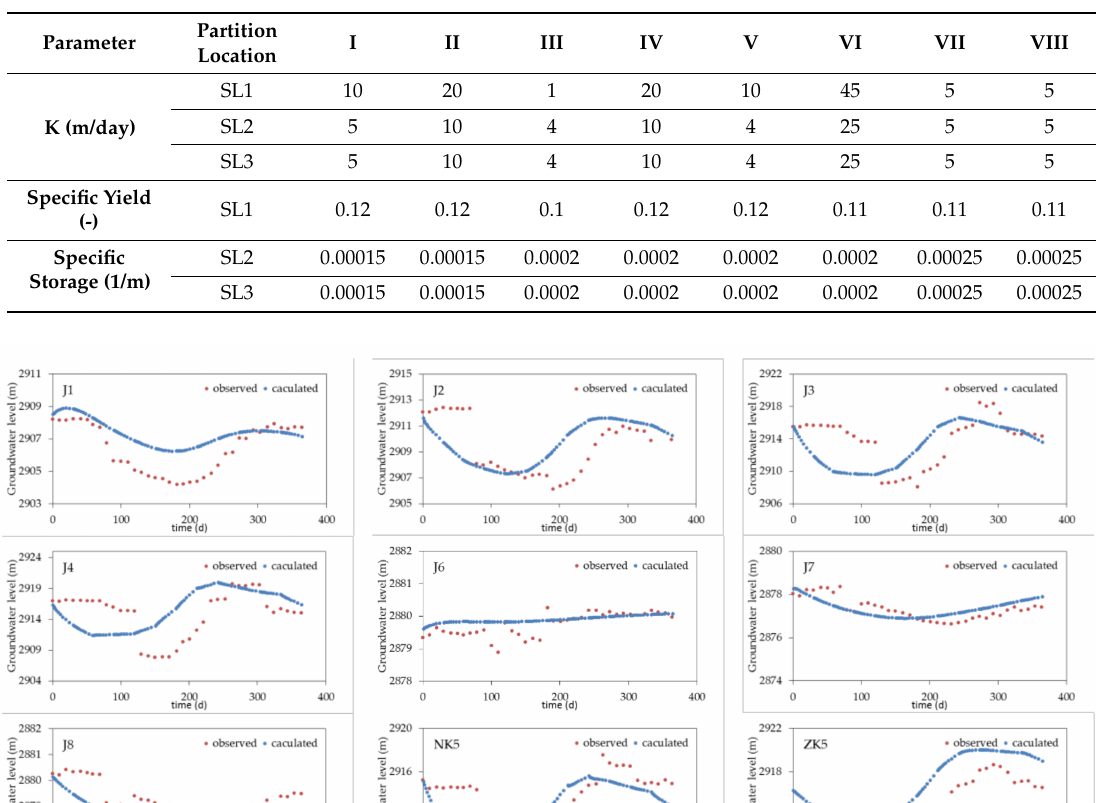
Figure 14. Adjusted division of hydrogeological parameters. Table 3. Calibrated hydrogeological parameters in the local groundwater model.